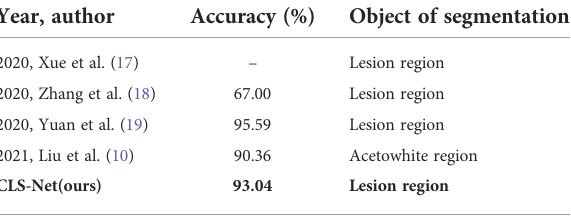
TABLE 5 Comparison of the proposed model with recent